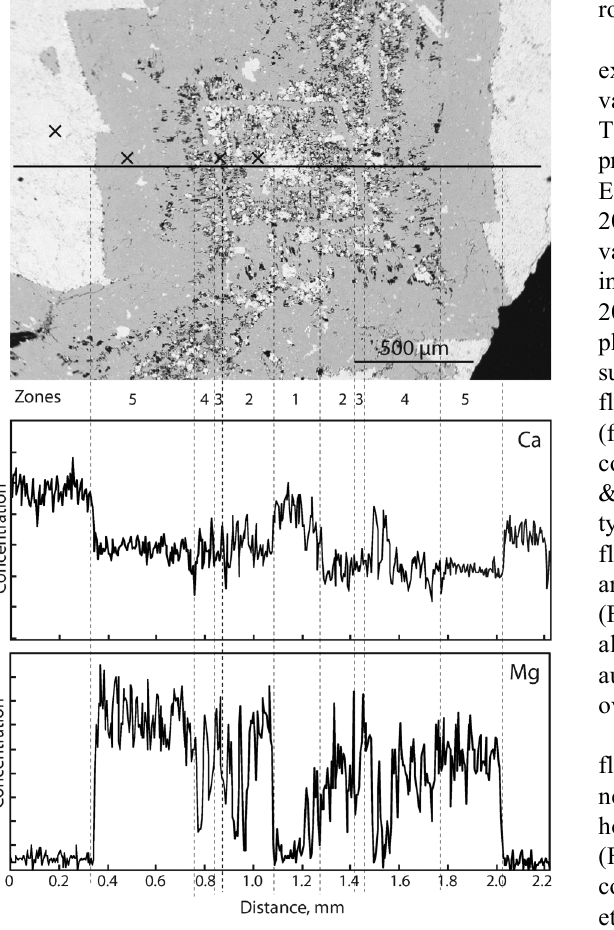
Fig. 14. The δ 13 C values of the dolostones/dolomites range from (cid:150) 4.48(cid:137) to + 0.99(cid:137) and δ 18 O values from (cid:150) 7.54(cid:137) to (cid:150) 3.42(cid:137). In limestones δ 13 C ranges